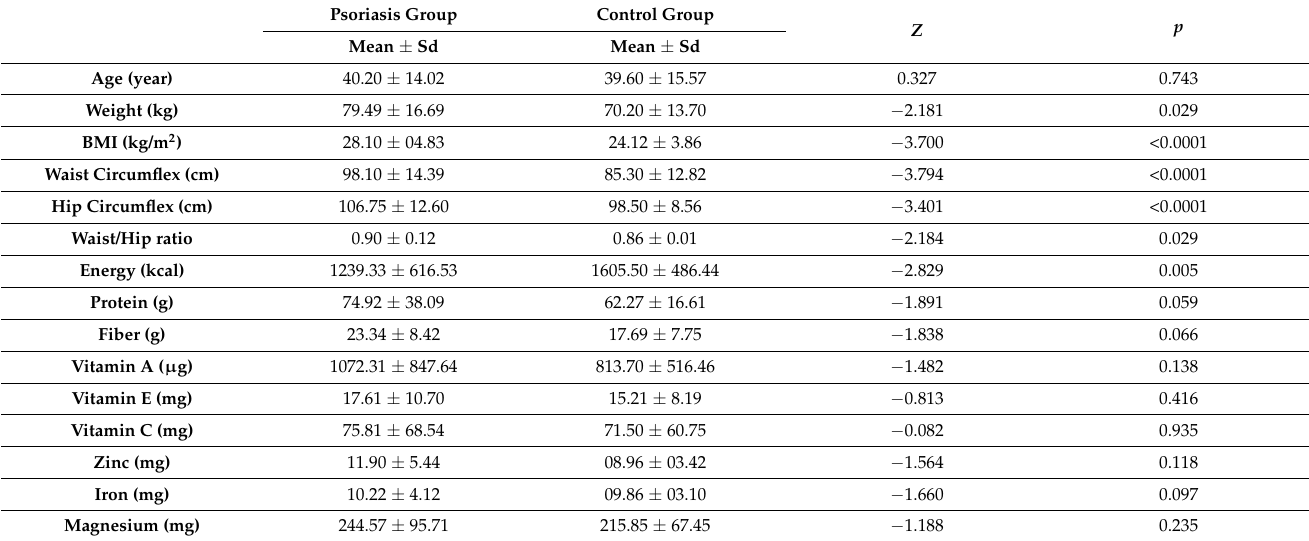
Table 2. Comparison of groups’ age, anthropometric measurements, daily energy intake, some macro and